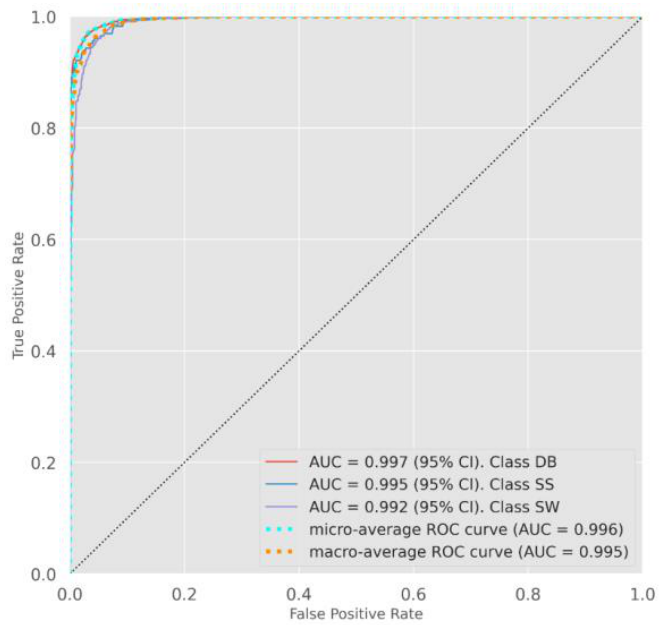
Figure 13. ROC curves of XGBoost Classifier for three classes (‘ST’, ‘DS’, ‘I’).